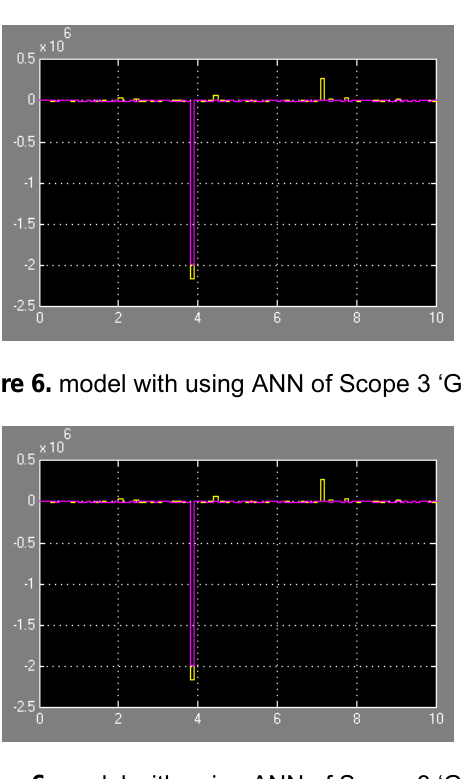
Figure 6. model with using ANN of Scope 3 ‘G 2 (u)’